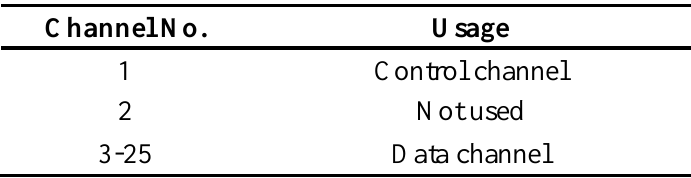
Table 3. Channel usages of the suggested